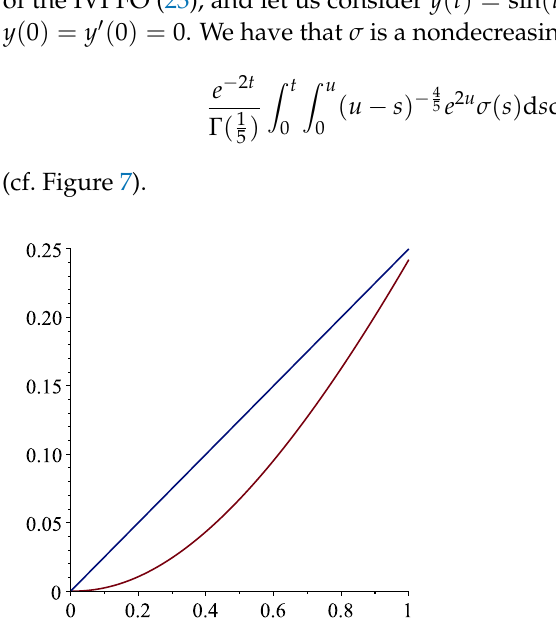
(cid:82) t (cid:82) u ( u − s ) − 4 5 e 2 u σ ( s ) d s d u and m Γ ( 1 0 0 ) 5